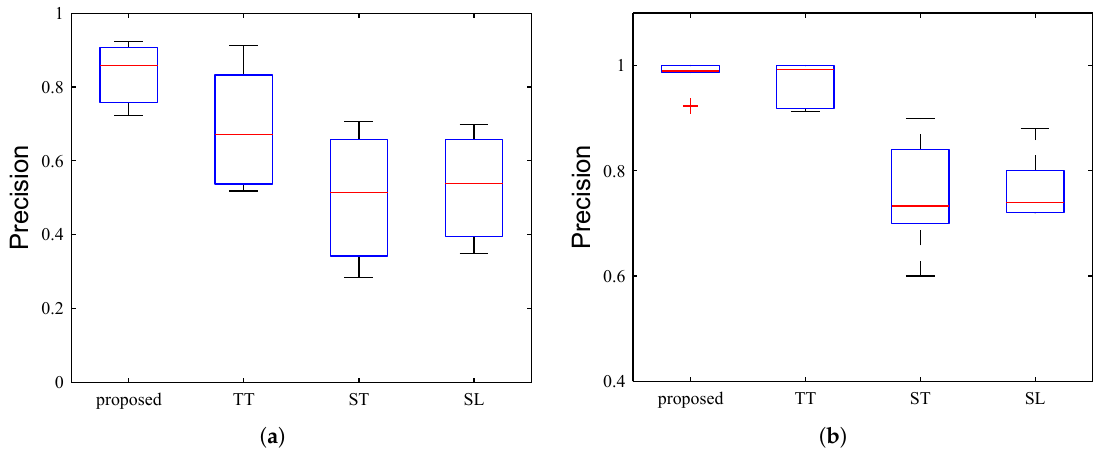
Figure 12. Performance of Single-Evolving Anomaly Detection. ( a ) The first way; ( b ) The second